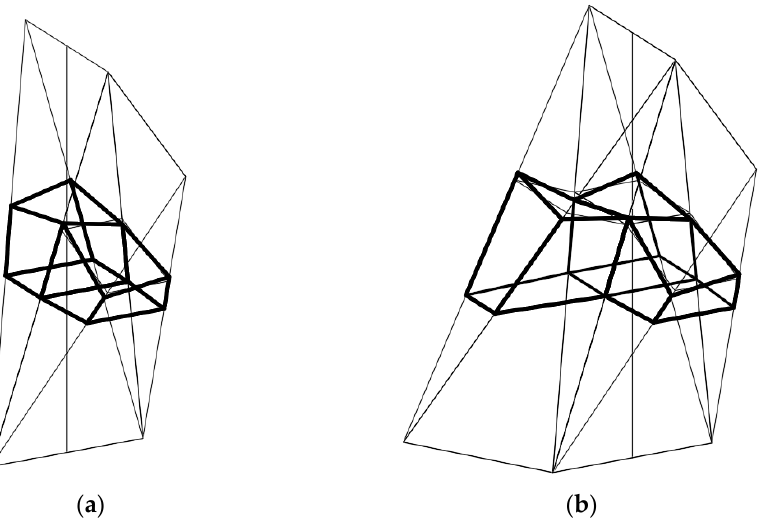
Figure 7. Subsequent meshes positioned in two orthogonal directions of the designed reference net- work Γ , the eaves network B v , and the complex structure Σ : ( a ) the first orthogonal direction, and ( b ) two orthogonal